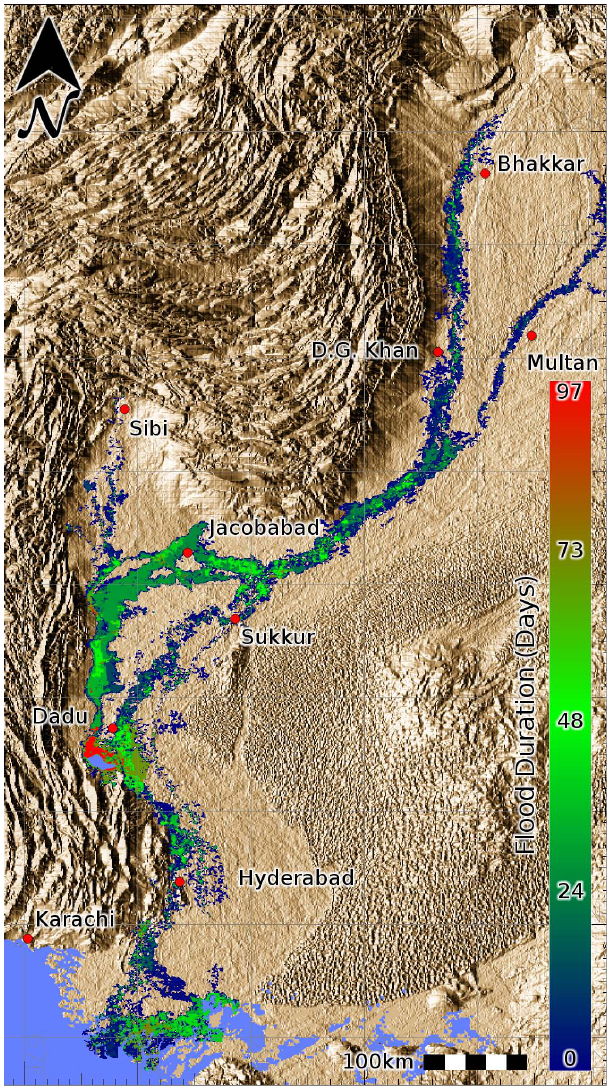
Fig. 17. Map showing the extent and duration of inundation sur- rounding the Indus and Chenab rivers as derived from satellite radar data acquired between July and October 2010.